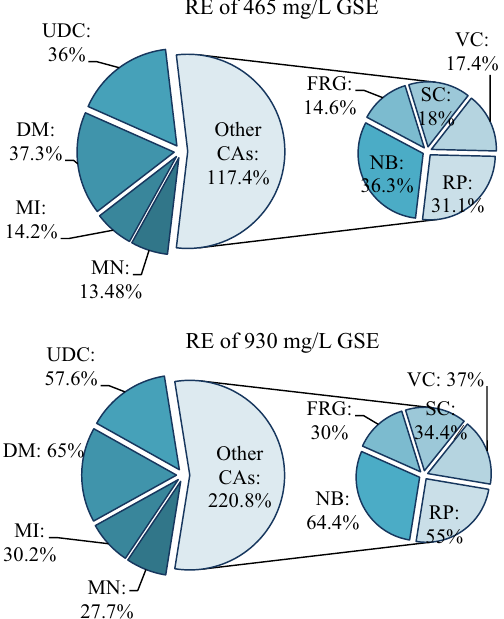
Figure 8. RE of 465 mg/L and 930 mg/L GSE against genotoxic effects of KBrO 3. MI: mitotic index, MN: micronucleus, FRG: fragment, SC: sticky chromosome, VC: vagrant chromosome, UDC: unequal distribution